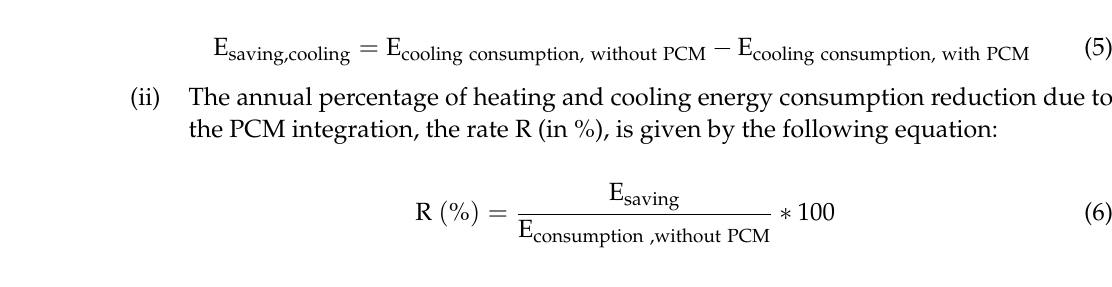
Table 3. Thermal properties of